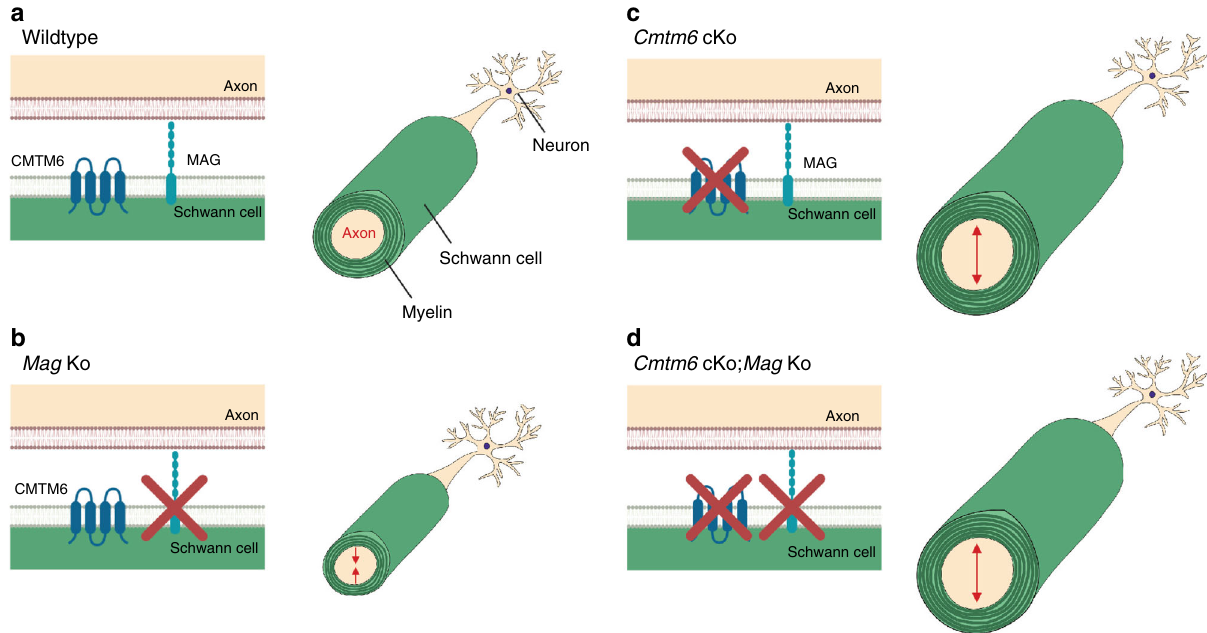
Fig. 6 Model of the role of adaxonal myelin proteins CMTM6 and MAG in regulating the diameters of peripheral axons. a , b Compared to wild-type mice ( a ), the diameters of peripheral axons (light brown) are decreased in the absence of myelin-associated glycoprotein (MAG) ( b ) (see ref. 14 and Supplementary Fig. 12), which is speci fi cally expressed by Schwann cells (green). This implies that MAG-dependent signaling by Schwann cells increases axonal diameters 14 . c The diameters of peripheral axons are markedly increased (arrows) when Schwann cells lack CMTM6, indicating that Schwann cells utilize CMTM6 to restrict axonal diameters. d Diameters of peripheral axons are increased (arrows) when Schwann cells lack both MAG and CMTM6, indicating that loss-of-CMTM6-function overrides loss-of-MAG-function regarding axonal diameters. Schwann cells thus regulate the diameters of peripheral axons via adaxonal surface proteins including MAG and CMTM6. Scheme created by Maria A. Eichel with